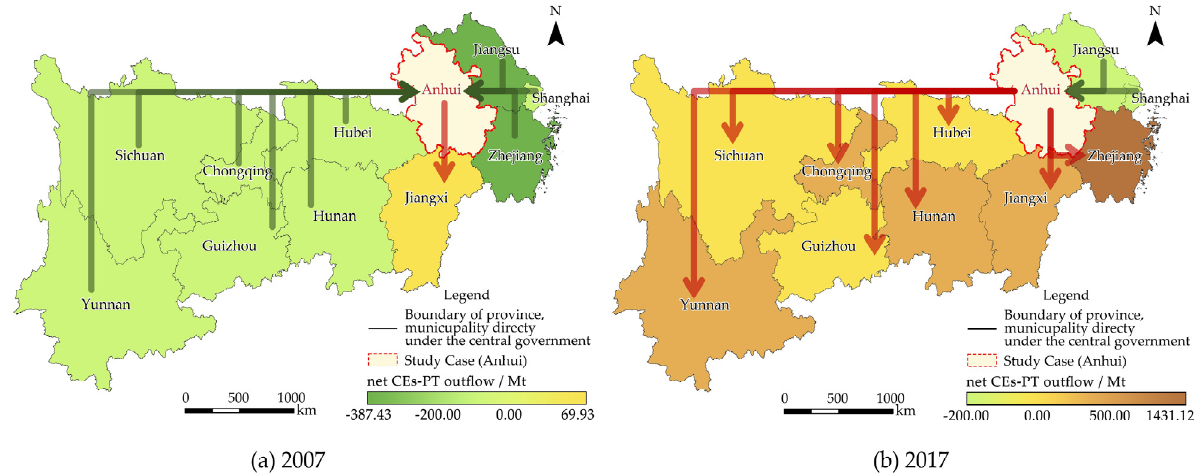
Figure 6. Spatial–temporal evolution of the net ECEs-IPT outflow in Anhui among the YREB from 2007 ( a ) to 2017 ( b